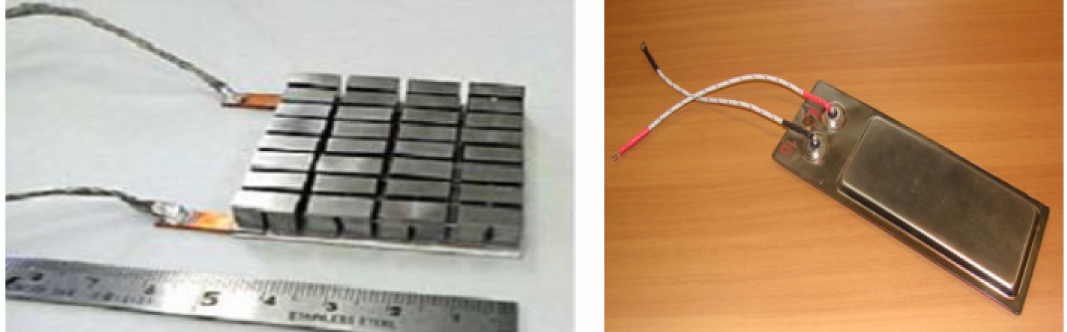
Figure 13. Photos of multistage thermoelectric module and capsulated module in